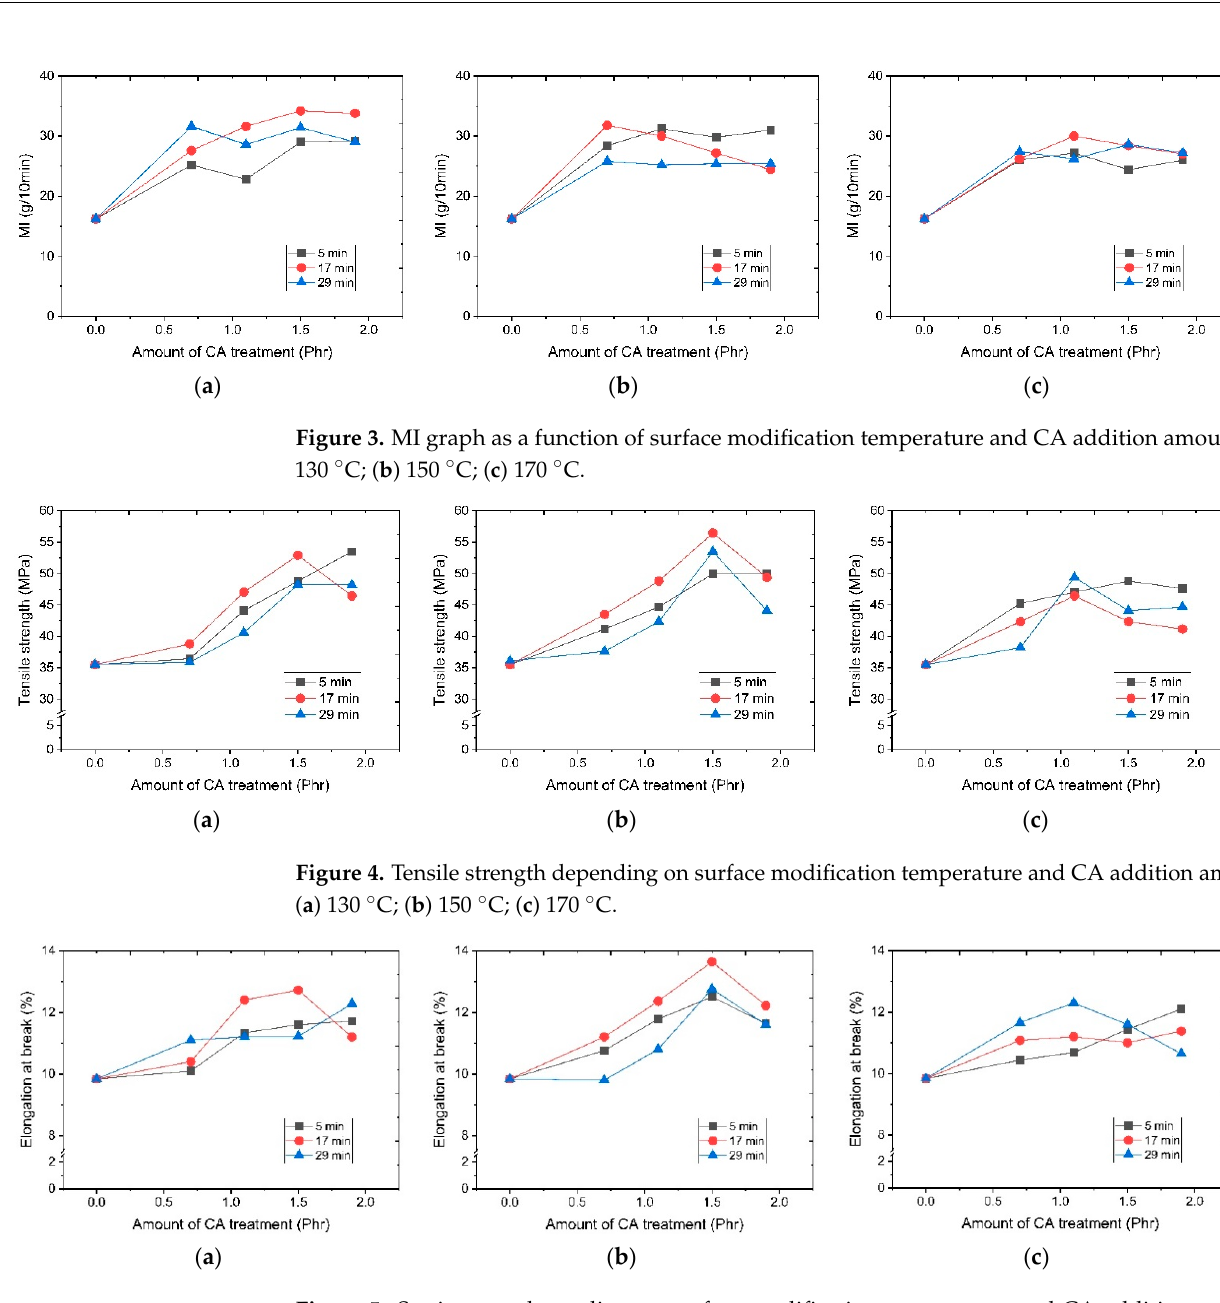
Figure 6. Schematic diagram of the combination of isotactic and atactic structures: ( a ) isotactic polypropylene structural formula; ( b ) structural formula consisting of atactic and isotactic single bonds (left), and structural formula of block copolymer in which many isotactic structures are formed and combined (right), Blue line is isostatic block, Red line is Atactic block. Modified inorganic flame retardant surface properties were determined. Figure 7 shows SEM images of surfaces of specimens not treated with the CA modifier, a specimen treated with the CA modifier, and a specimen after the tensile test. The surface of the untreated Mg(OH) 2 test piece was relatively rough. In the test piece after the tensile test, many fractures occurred due to tensile stress. Many holes were observed on the surface. It could be seen that the combination of the two did not occur smoothly. Contrary to this, the surface of the injection specimen treated with silane was relatively smooth. It was confirmed that the compound was in a good dispersion state. Mg(OH) 2 and resin had a strong bond. On the other hand, in the specimen to which an excessive amount of CA was added, aggregated Mg(OH) 2 was not dispersed in the resin. It existed as an impurity in the resin. Thus, the surface of the injection specimen was not uniform. As a result, it was confirmed that the physical properties were also lowered. In order to minimize the dry flame retardant content and increase the flame retardant effect, properties of each composition in which a melamine-based and phosphorus-based flame retardant was added as an additive to a single PP material in a range of 10 to 50 phr were evaluated separately from the previously modified material. Figure 8 shows a graph comparing tensile strength and hardness characteristics as a function of the type and content of flame retardants. In the case of MPP (melamine polyphosphate), the tensile